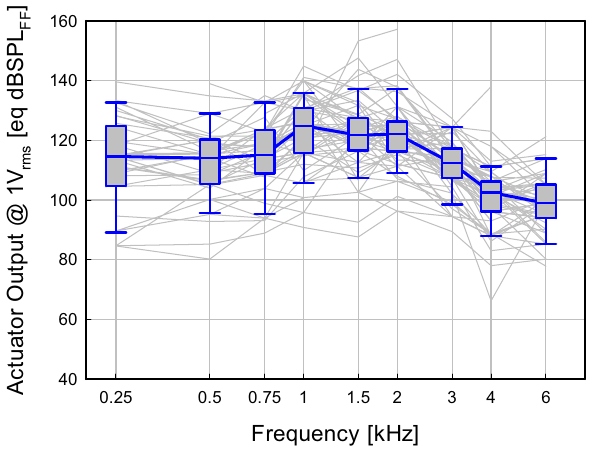
Figure 5. Estimated equivalent sound pressure in sound field [eq dB SPL FF ] generated by the Codacs at an input of 1V rms to the actuator. Box plots show median responses of all ears (N = 77) and thin grey lines individual results.